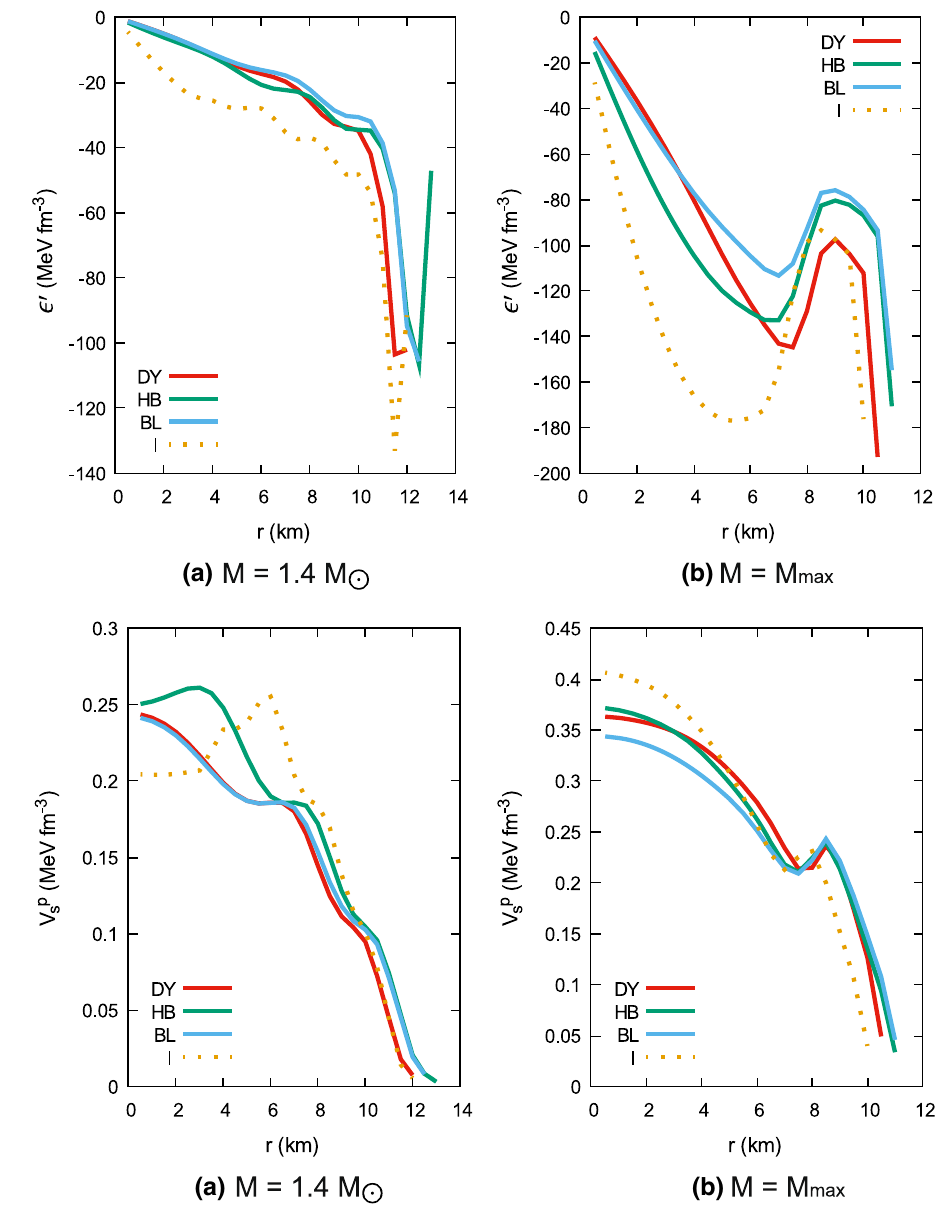
Fig. 7 The sound of speed for radial pressure of anisotropic models NSs and its isotropic (I) for M = 1 . 4 M (cid:6) and M = M